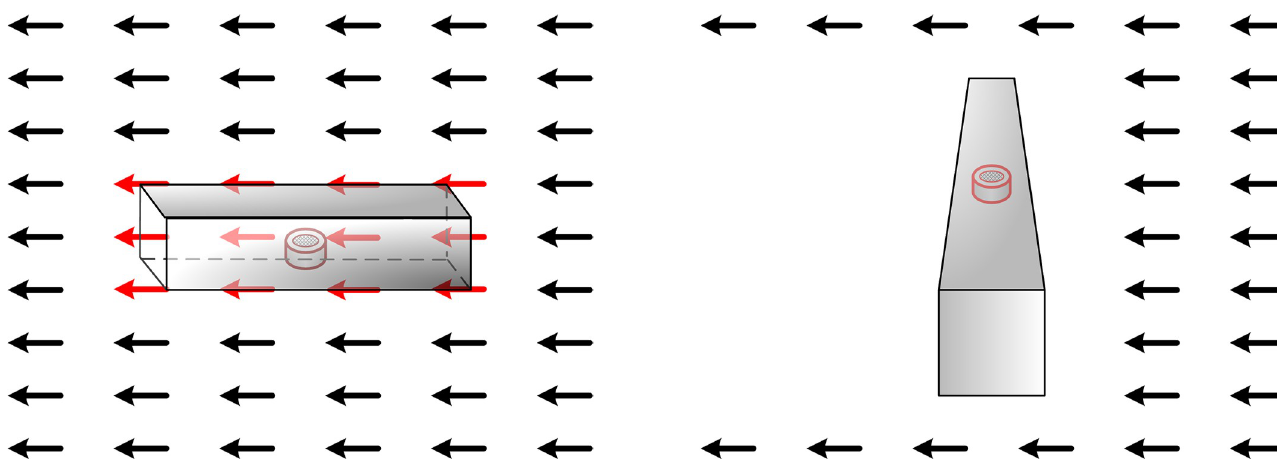
Fig 3. Basic method of measuring wind direction using the airflow tunnel. Measurement method when the airflow tunnel is (A) parallel and (B) perpendicular to the wind vector.